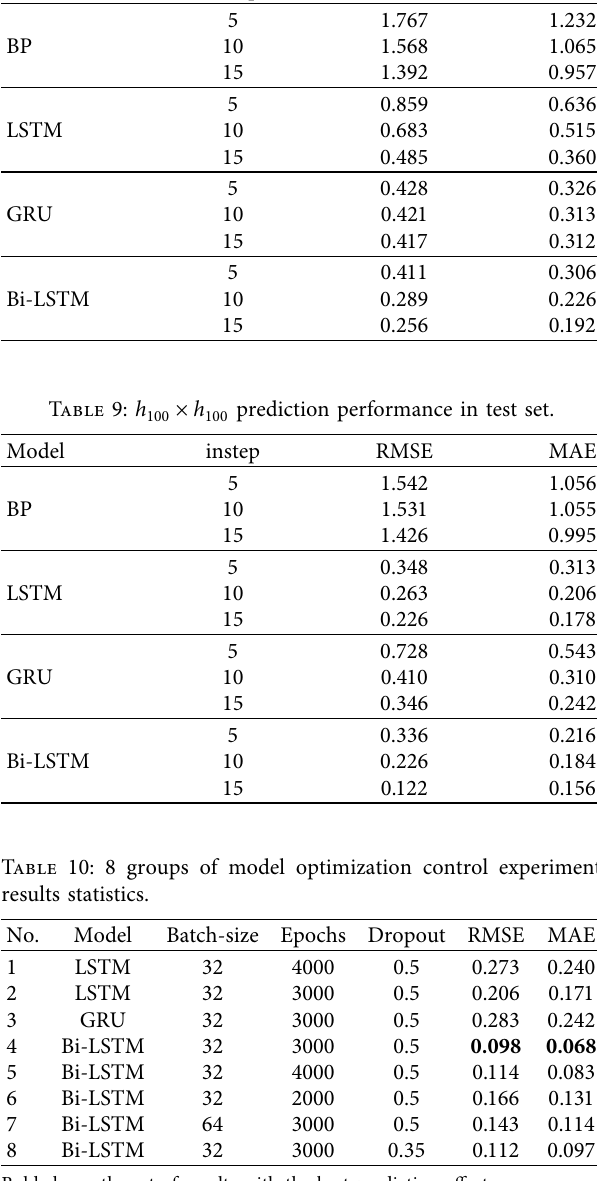
Table 8: h Model